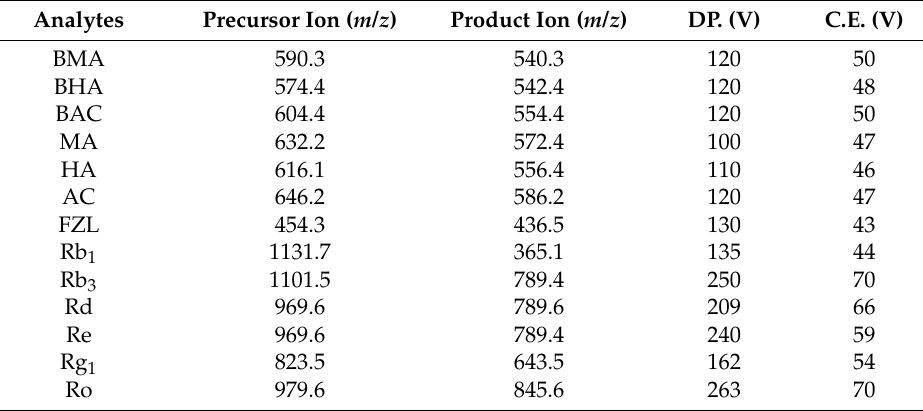
Table 2. Mass spectra properties of 13